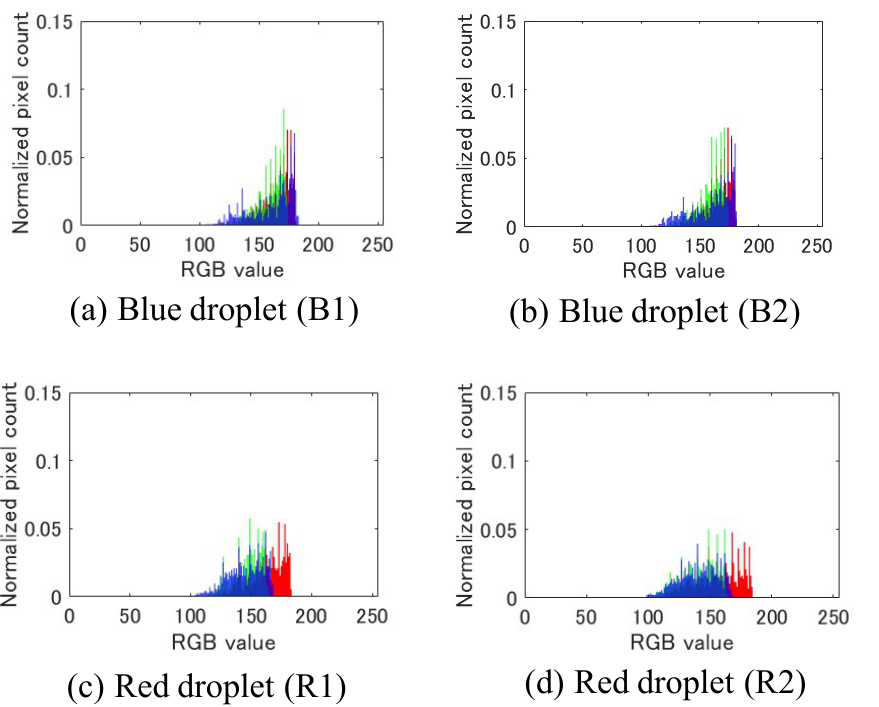
Figure 11. Color histograms of droplets. The red bars represent the red histogram, the green bars represent the green histogram, and the blue bars represent the blue